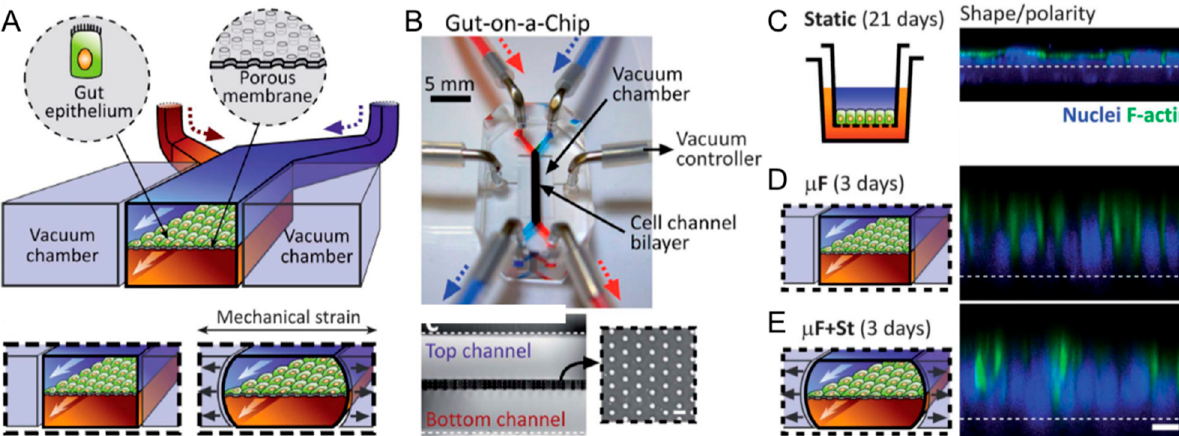
Figure 4. A gut-on-a-chip platform with microfluidic actuators. ( A ) Schematics and ( B ) images of the membrane-based gut-on-a-chip microdevice with pneumatic actuators. On the platform, the cultured Caco-2 cell monolayer is exposed to the low-level fluid flow (perfused from microchannel inlets) and cyclic biomimetic peristaltic motion (reproduced by pneumatically activated vacuum chambers). Morphology of the Caco-2 epithelial cells ( C ) cultured in the static transwell system and in the gut-on-a-chip with microfluidic flow ( D ) without or ( E ) with the application of cyclic mechanical strain (10%; 0.15 Hz) for three days. The confocal fluorescence views show a vertical cross section of the epithelium highlighting cell shape and polarity (nuclei in blue and F-actin in green). Scale bar is 20 μ m. Reproduced with permission from [75].